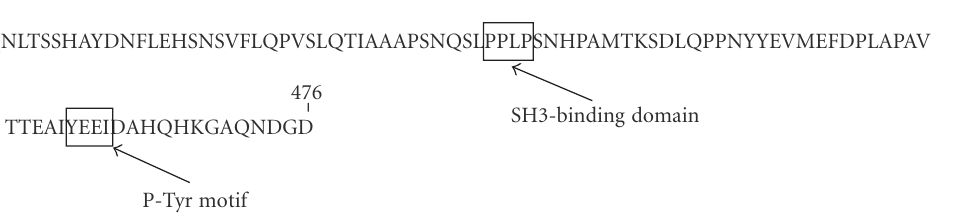
Figure 1: Amino acid sequence of the TOM1L clone that was picked up seven times in the yeast 2-hybrid assay. The SH3-binding domain (LPPLP) and the phosphotyrosine motif (P-Tyr) at the C-terminus of TOM1L are